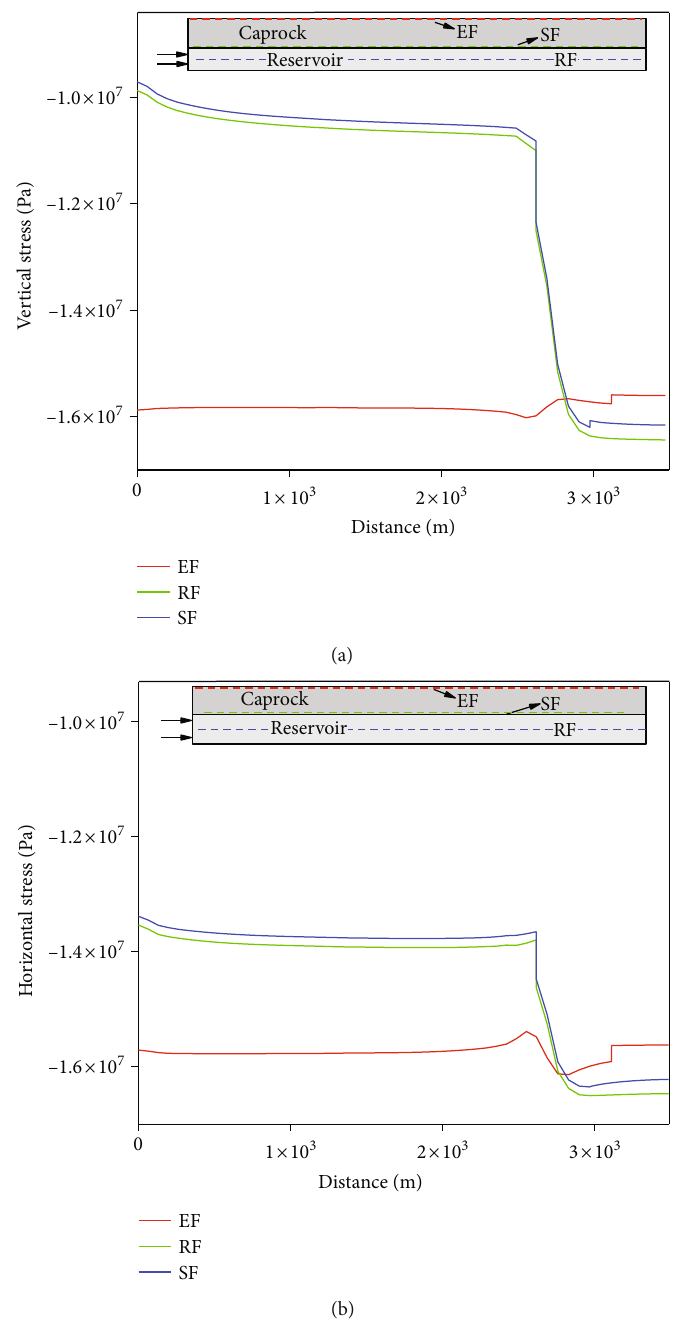
Figure 15: Stress curve of horizontal survey line. (a) Vertical stress. (b) Horizontal